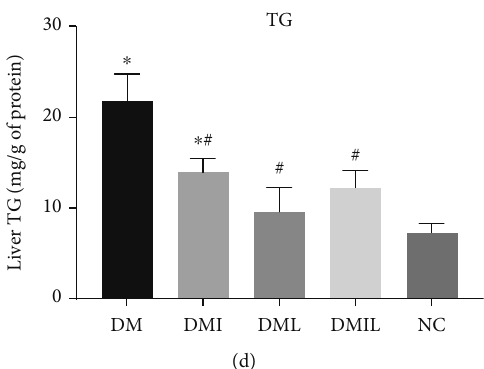
Figure 1: E ff ects of liraglutide on histological alterations in DM mice. (a) HE staining of liver tissue. Scale bar is 100 μ m in the images. (b) Hepatic steatosis score. (c) PAS staining of liver tissue. (d) Triglyceride content in the liver. Data are expressed as mean ± SD ( n = 4 /group); p < 0 : 05 was de fi ned as statistically signi fi cant. DM: saline-treated type 1 diabetes group. DMI: insulin treatment group; DML: liraglutide treatment group; DMIL: insulin+liraglutide treatment group; NC: normal glucose tolerance group; ∗ : compared to NC; #: compared to DM; † : compared to DMI; ‡ : compared to